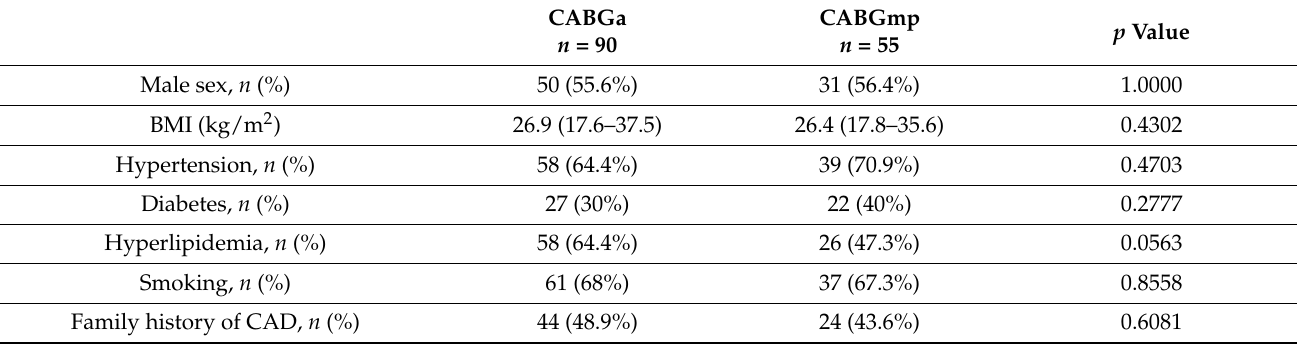
Table 2. Baseline characteristic of patients with significant MR treated by CABGa or